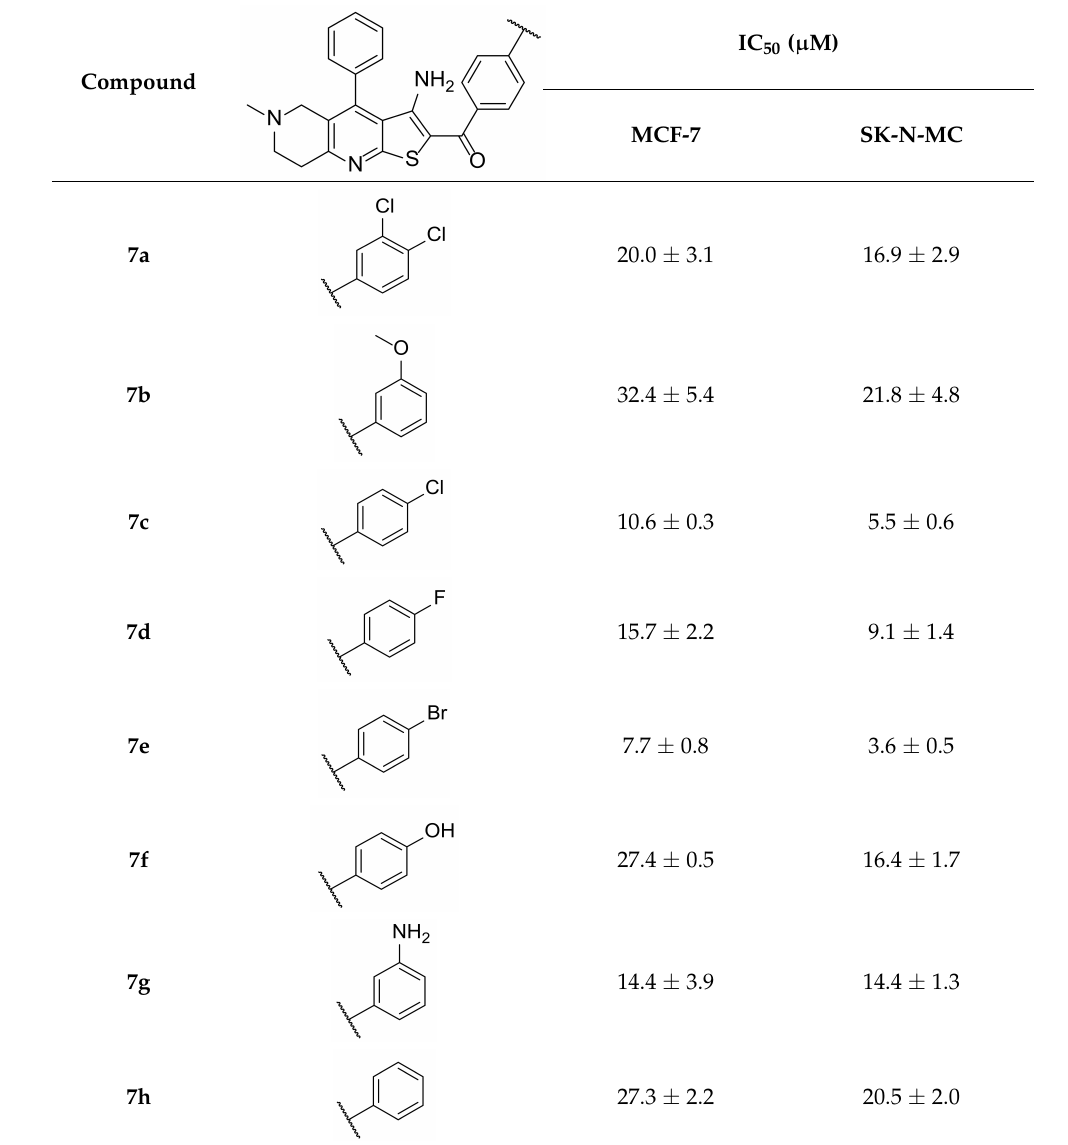
Table 2. IC 50 values for the antiproliferative activity of compounds 7a – h in the MCF-7 and SK-N-MC cell lines: exploration of SAR with modifications of the phenyl ring